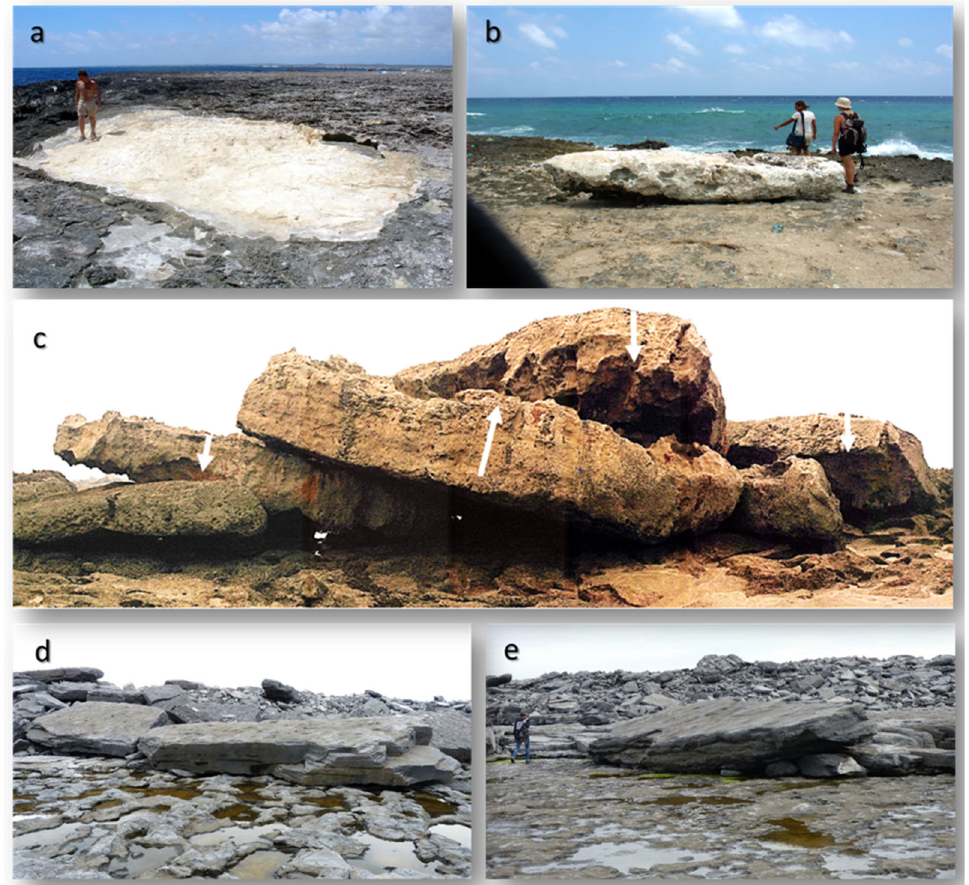
Figure 5. Relation of boulder forms to transport energy: ( a , b ) lifting and overturning from hurricane waves 2004 on Bonaire (southern Caribbean); ( c ) imbrication train from partly overturned boulders (axes up to 9 m) at +10 m during the 1755 CE Lisbon Tsunami in Morocco; ( d , e ) platy boulders of 50+ tons at +9–11 m mhw and up to 200 m from the coastline at the SE coast of Inishmaan.